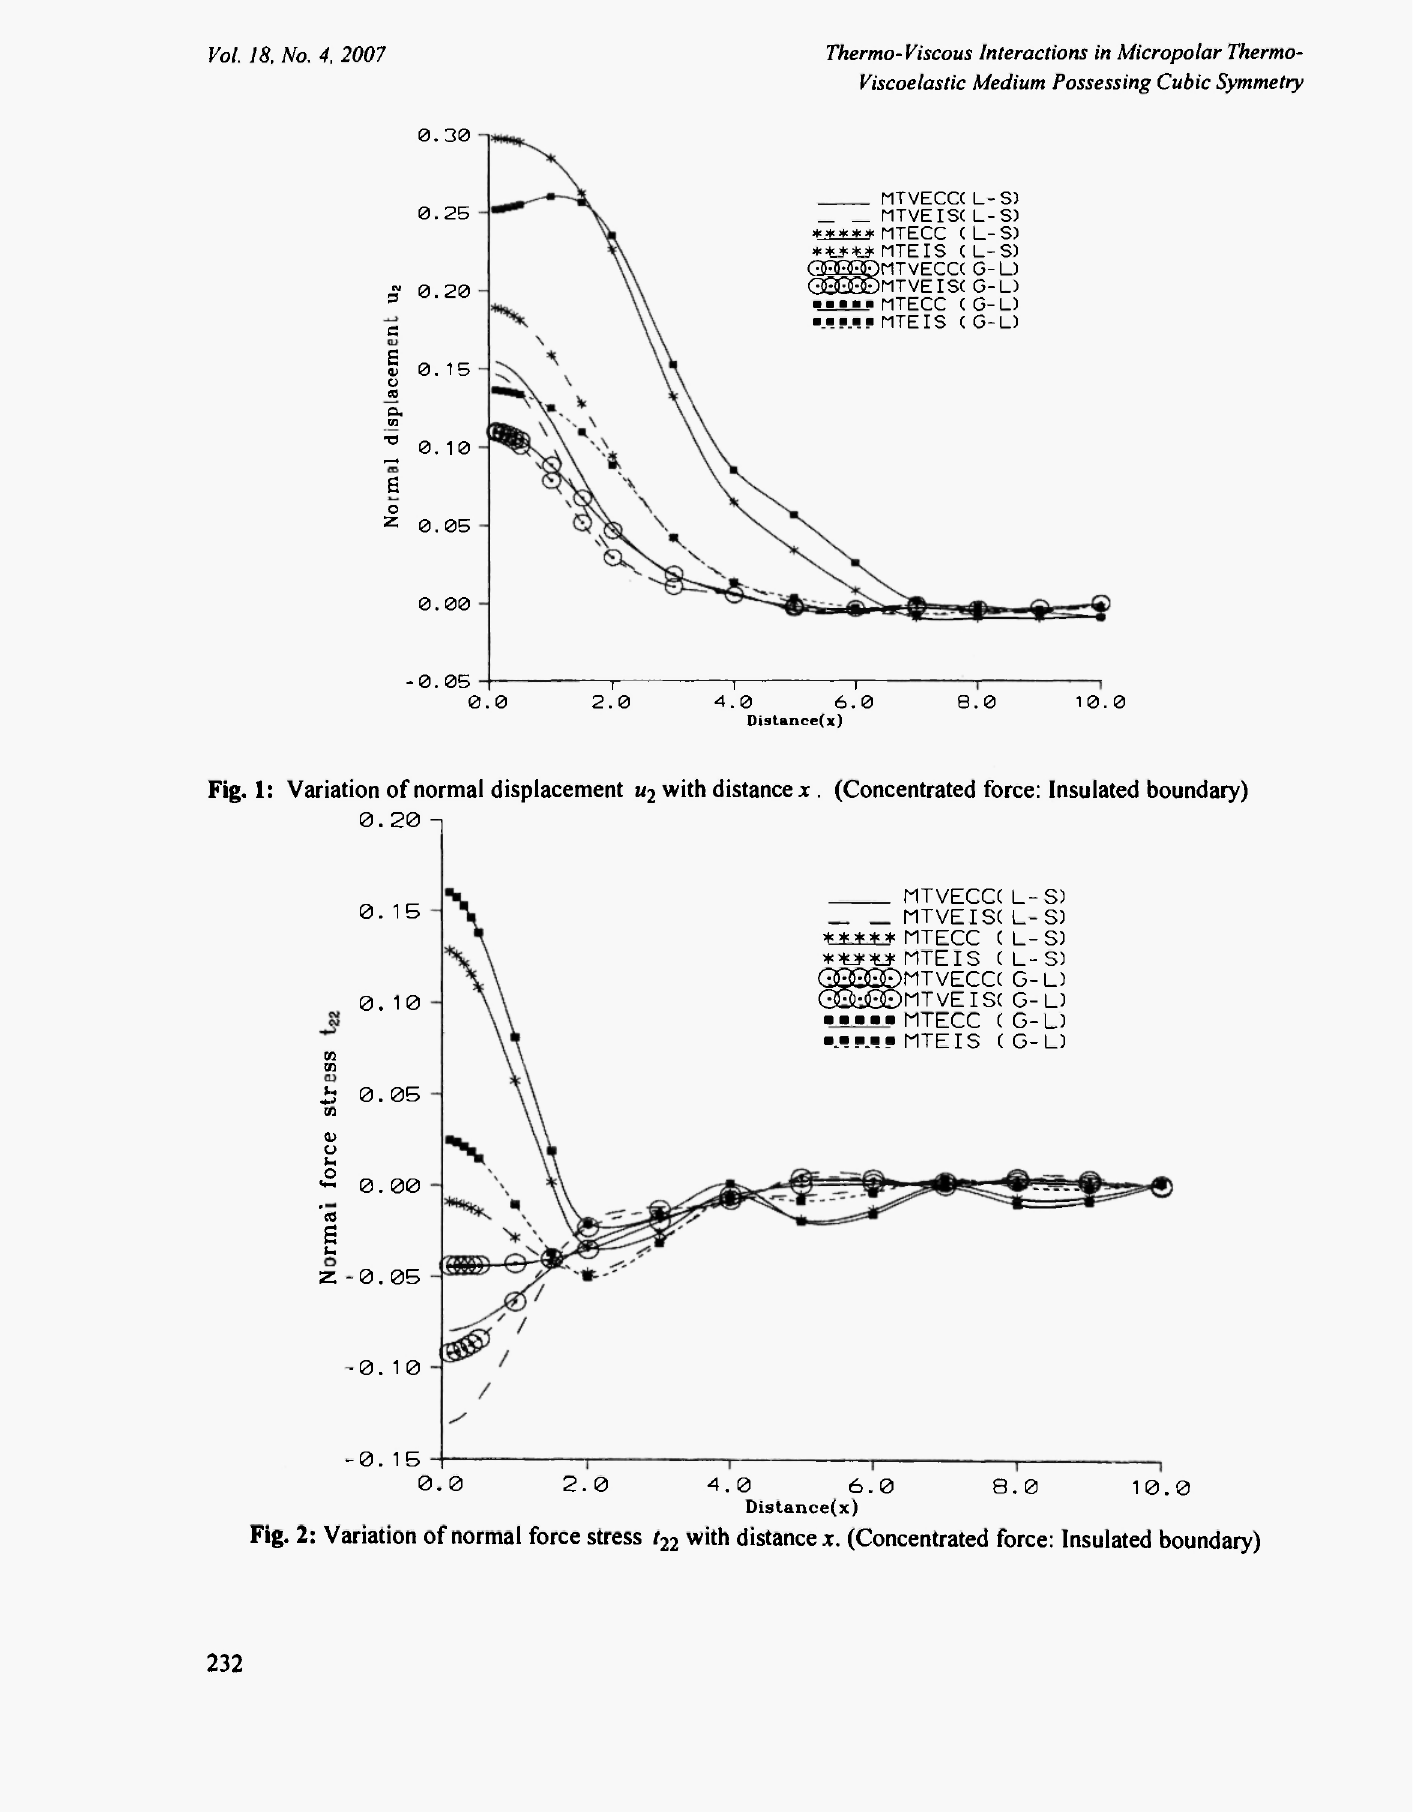
Fig. 1: Variation of normal displacement u 2 with distance χ . (Concentrated force: Insulated boundary)